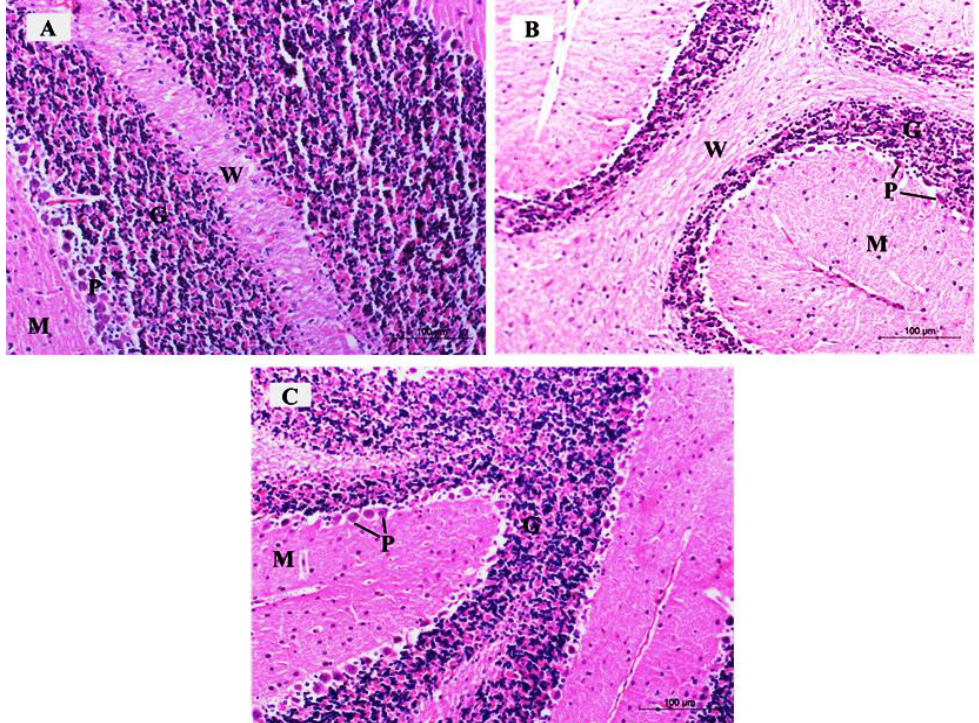
Figure 8. Photomicrographs of H&E-stained sections of the mouse cerebellar cortex in the different study groups; ( A) control group and ceftriaxone group showing the molecular cell layer (M), Purkinje cell layer (P), and granular cell layer (G). The medulla formed of white matter fibers (W) is also demonstrated. ( B ) ARS group exhibits a marked reduction of the density of neurons in the three cortical layers. ( C ) ARS + ceftriaxone group demonstrates obvious restoration of the cellular density of the three cortical layers. (Hx. &E. × 200).